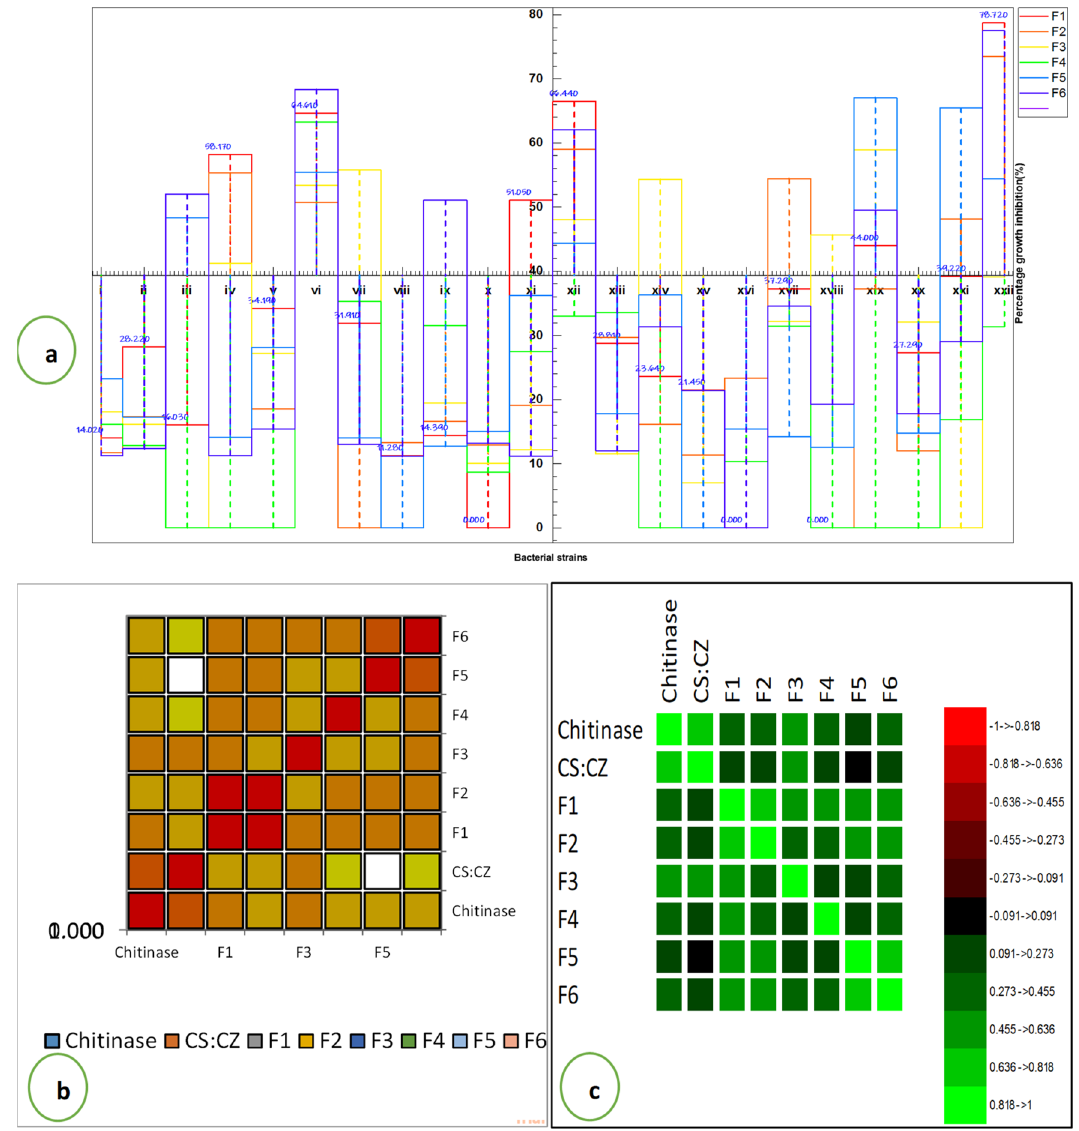
Figure 5. (a) Isolated microflora representing fungicidal activity expressed as percentage inhibition of; F1: Fusarium oxysporum ; F2; F. solani ; F3: Dematophora. necatrix 1 ; F4: Pythium amphanidermatum ; F5: D. necatrix 2 and F6: Rhizoctonia solani . where symbols: (i) Akura; (ii) Bona Nambal; (iii) Hugam; (iv) Hutmara; (v) Panzmulla; (vi) Rakh Chandipora; (vii) Tujar; (viii) Bomai; (ix) Brath; (x) Juhama; (xi) Kanispora; (xii) Fateh Pora; (xiii) Nowgam; (xiv) Rawalpora (xv) Rangreth; (xvii) Khunmoah; (xvii) Zakura; (xviii) Gulab Bagh; (xix) Ahmad Nagar (xx) Dhara; (xxi) Tailbal and (xxii) Batapora.; ( b ) Correlation map and (c) Correlation matrix pertaining to chitinase; CS: CZ and antifungal behavior against F1 ( F. oxysporum ): F2 ( F. solani ); F3 ( D. necatrix 1 ; F4 ( P. amphanidermatum ); F5 ( D. necatrix 2 ) and F6 ( Rhizoctonia solani